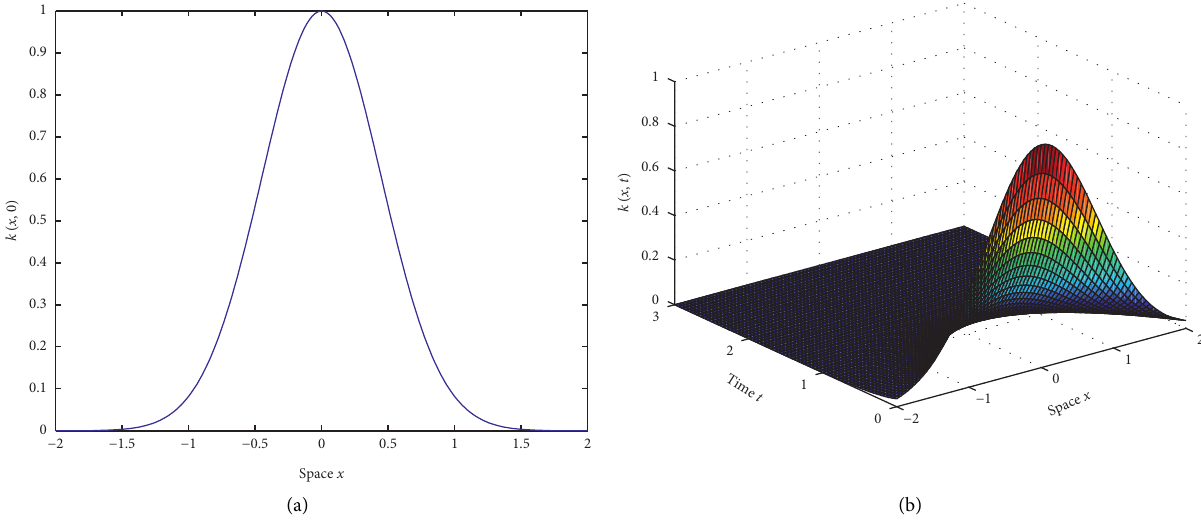
Figure 2: Evolution of the spatial capital distribution in the case n ( 1 − σ ) � A ( 1 − σ ) + ρσ − σ r 2